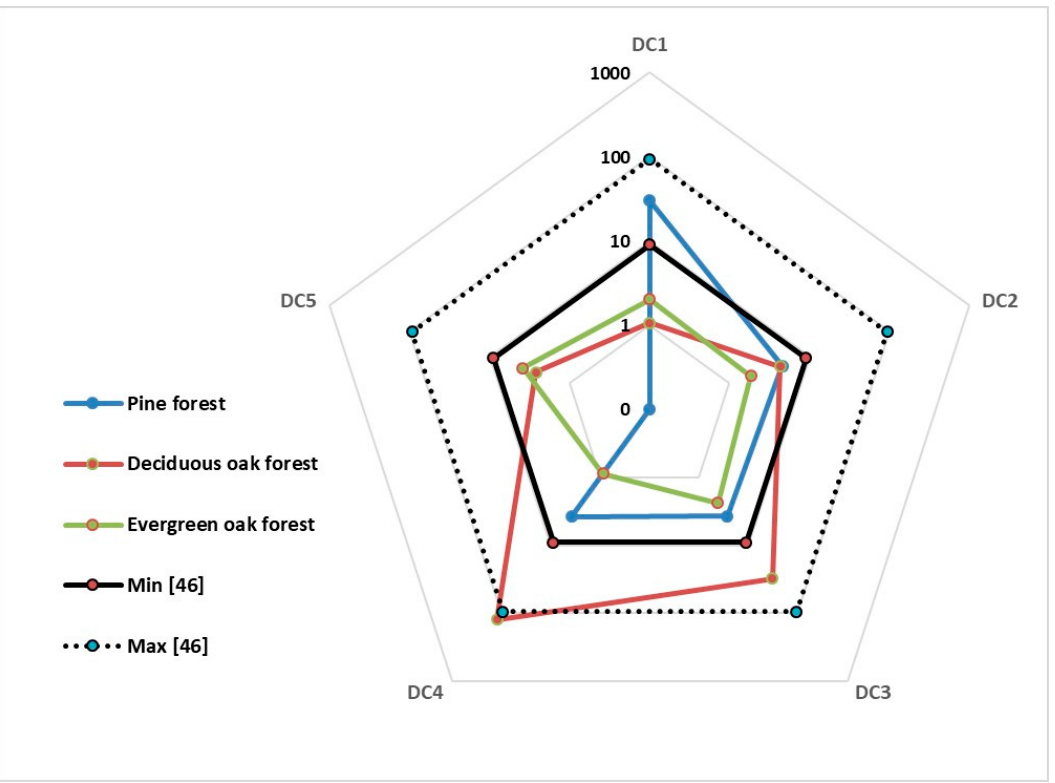
Figure 6. Deadwood presence (log m 3 /ha) for decay classes in the three forest types studied compared with reference [44]. Table 5. Logs and snag distribution per decay class (DC). Factorial ANOVA test for the parameter deadwood volume, HSD post hoc test was applied and the results showed three homogeneous groups, shown in the table by different letters.